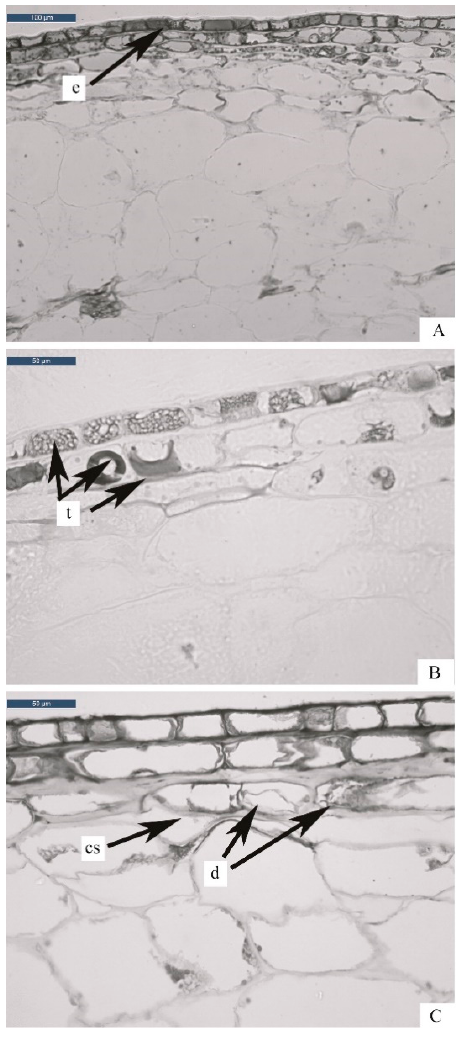
Figure 1. Transverse sections of blueberries samples: ( A ) raw or uncooked stained with Toluidine Blue (TBO); ( B ) raw or uncooked stained with tannin solution; ( C ) blanched stained with Toluidine Blue (TBO). Legend: e = epidermis; t = tannins; cs = cell separation; d = dehydration.